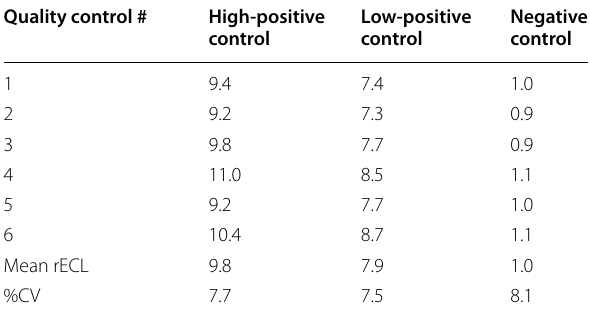
%CV coefficient of variation, ECL electrochemiluminescence, rECL mean sample ECL value divided by mean plate negative control ECL value